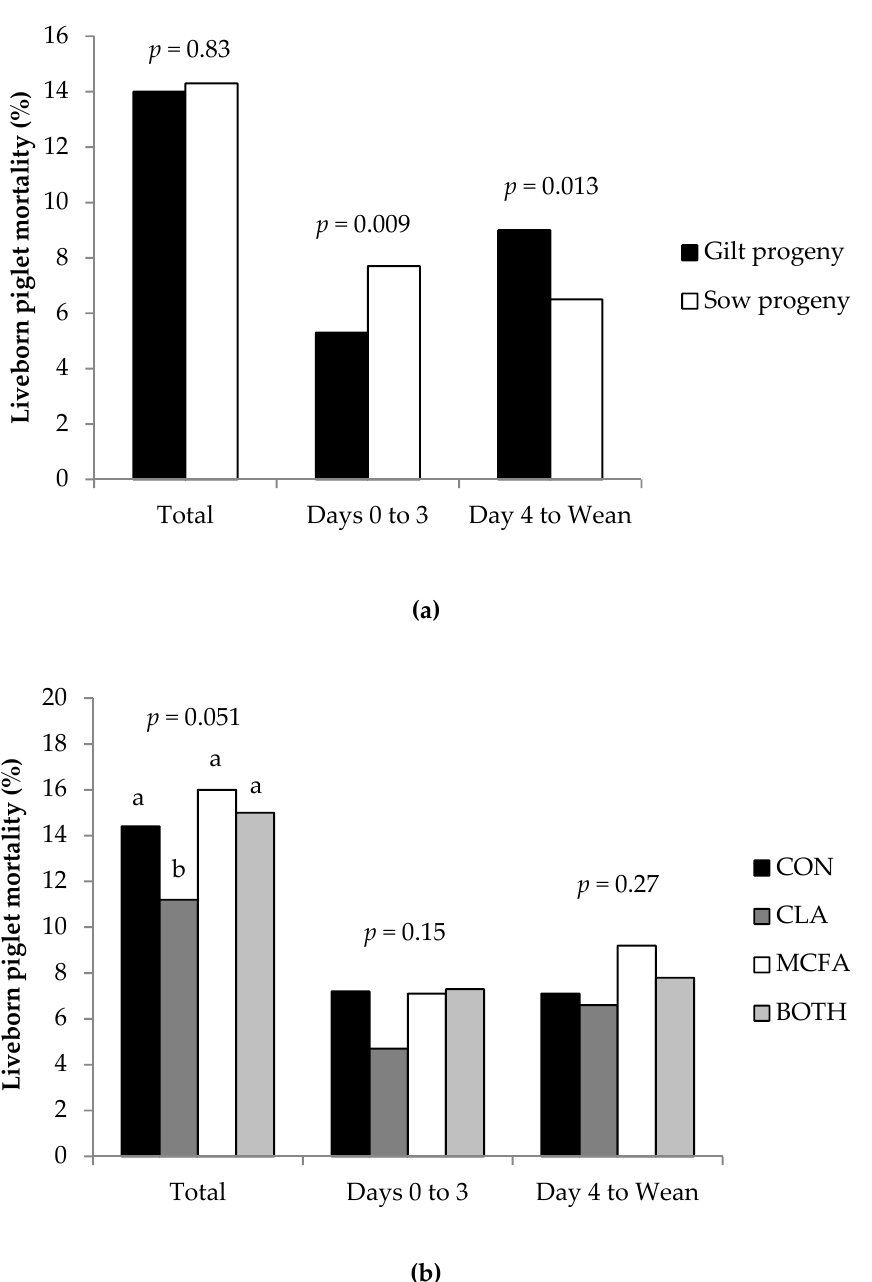
Figure 3. Effect of ( a ) dam parity (primiparous versus multiparous; gilt versus sow progeny) and ( b ) late gestation and lactation diet on pre-weaning liveborn piglet mortality. ab Different superscripts denote values that are significantly different ( p < 0.05).